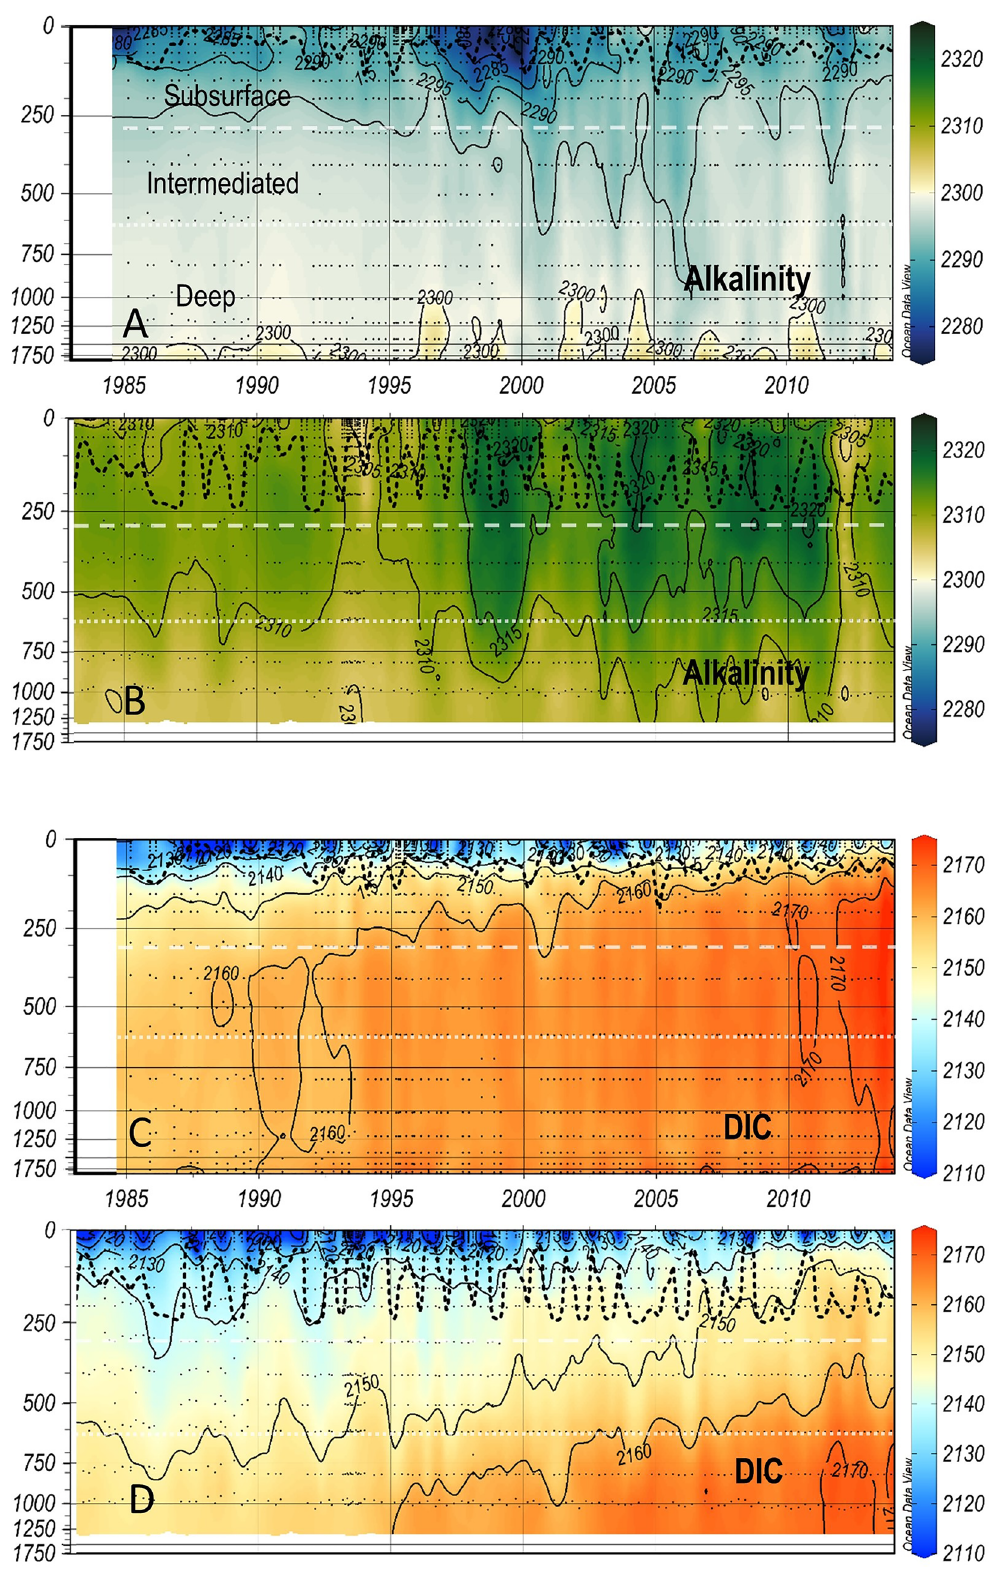
Figure 3. As Fig. 2 for alkalinity and DIC at IS-TS ( A , C ) and at IRM-TS ( B , D